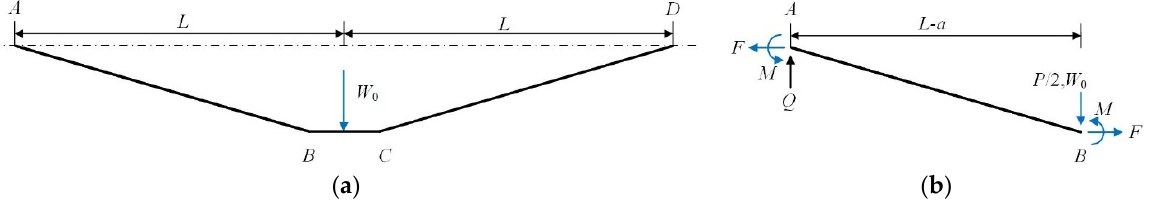
Figure 2. Analysis on the plastic neutral surface of a slender sandwich beam for global deformation pattern: ( a ) Transverse deflection profile; ( b ) free body diagram.